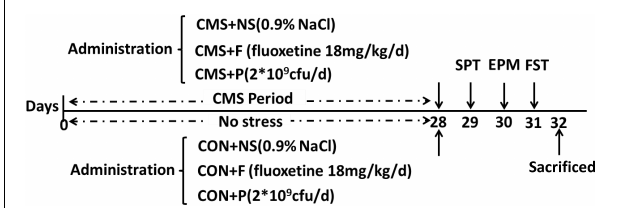
FIGURE 1 | Experimental design. Representation of the study design. C57BL/6 mice were fed for a total of 4 weeks with a mixture of three probiotics ( Lactobacillus helveticus R0052, L. plantarum R1012 , and Bifidobacterium longum R0175 ), the antidepressant fluoxetine, or saline.